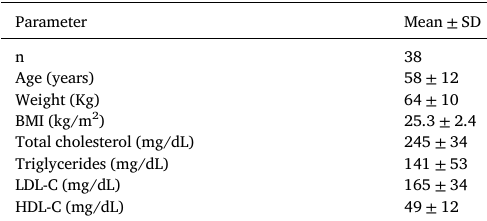
Table 2 Subjects characteristics at